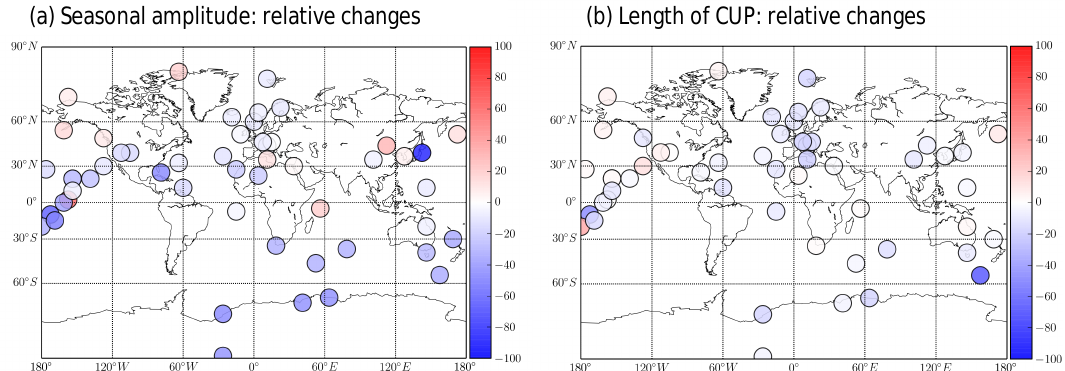
Figure 7. Changes in the mean seasonal cycle of the atmospheric CO 2 concentrations after step 3 of the optimization at all atmospheric stations. Left: relative changes (in percentage) between the prior of step 3 and posterior absolute model–data differences for the amplitude of the seasonal cycle. Right: same metric but for the length of the carbon uptake period (CUP), measured as the sum of the days when the de-trended concentrations are negative (see